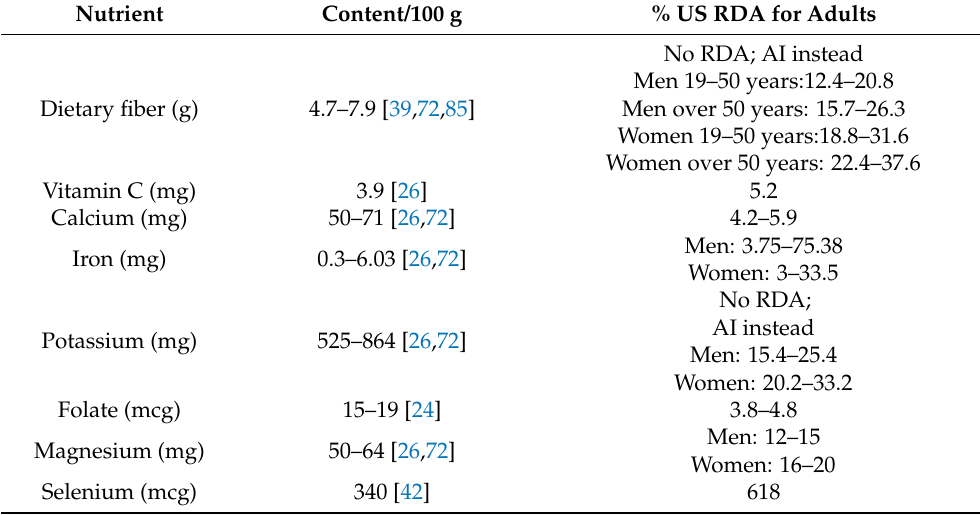
Table 2. Reported micronutrient and fiber content of select date fruit varieties per 100